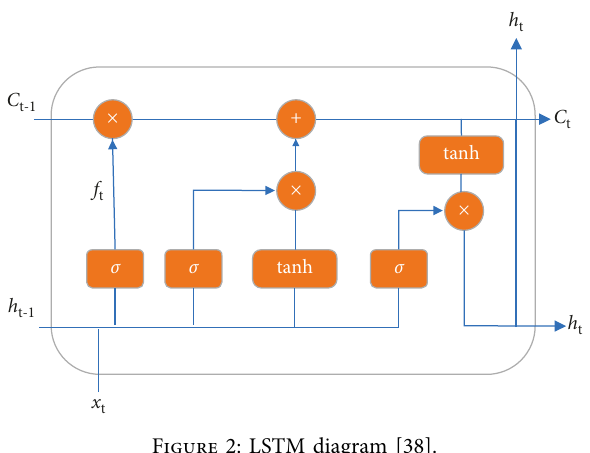
Figure 2: LSTM diagram